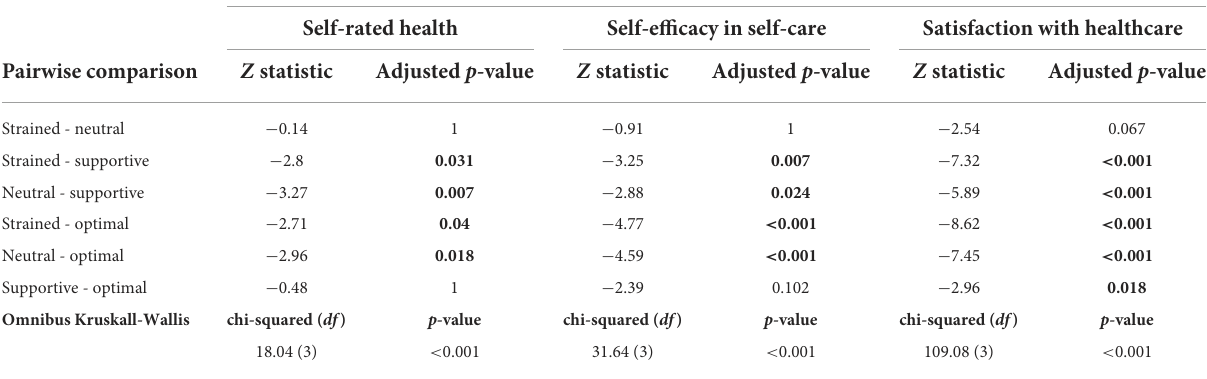
TABLE 8 Pairwise comparisons of exogenous variables between latent profiles at T1 ( N =